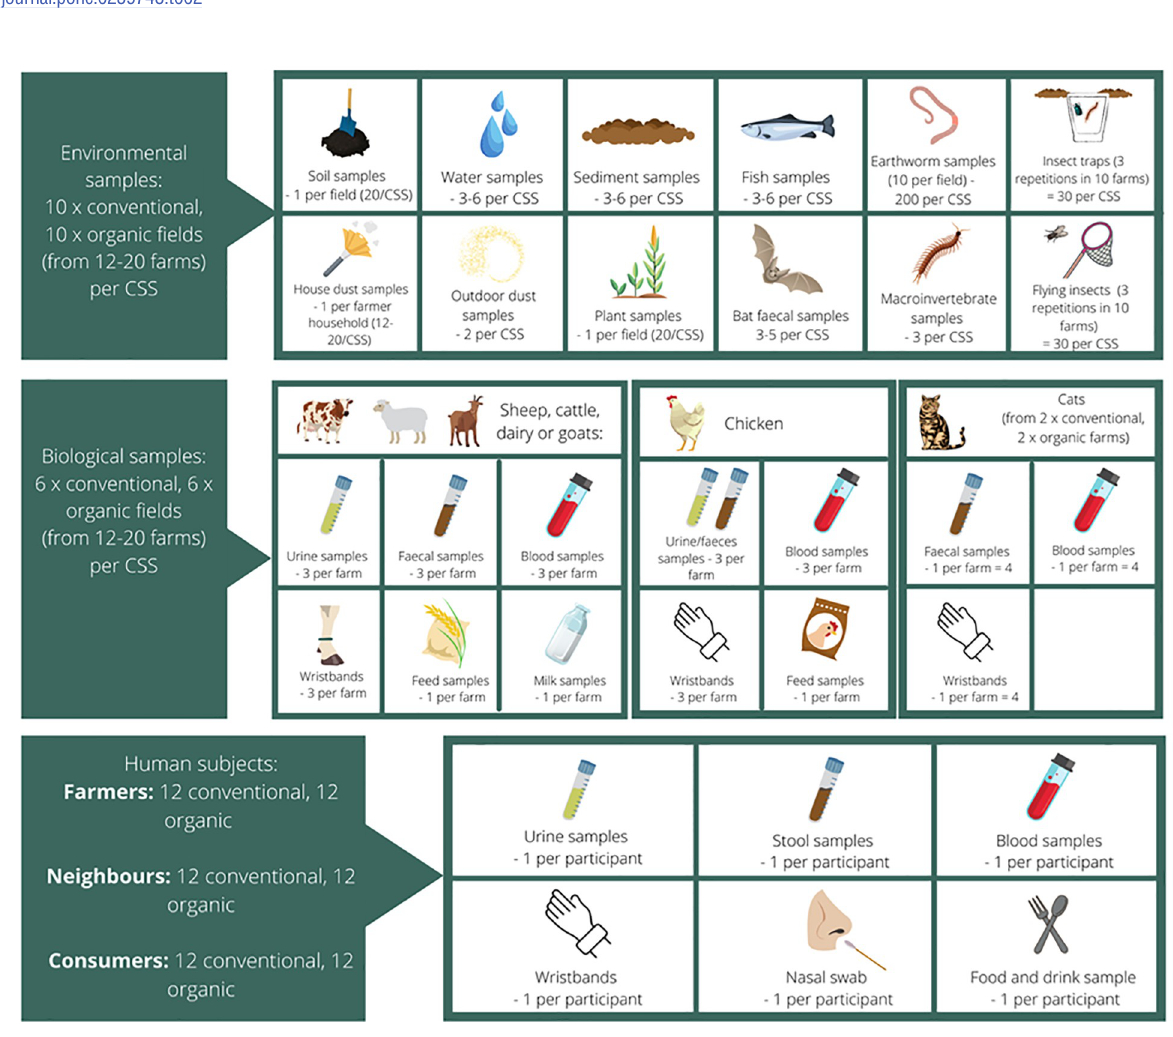
Fig 3. Overview of matrices and populations sampled in SPRINT Case Study Sites (CSS) and respective sampling effort. Each CSS includes 20 fields (10 conventional/integrated and 10 organic). A maximum of two fields are selected per farm; at least 6 organic and 6 conventional farms are selected per